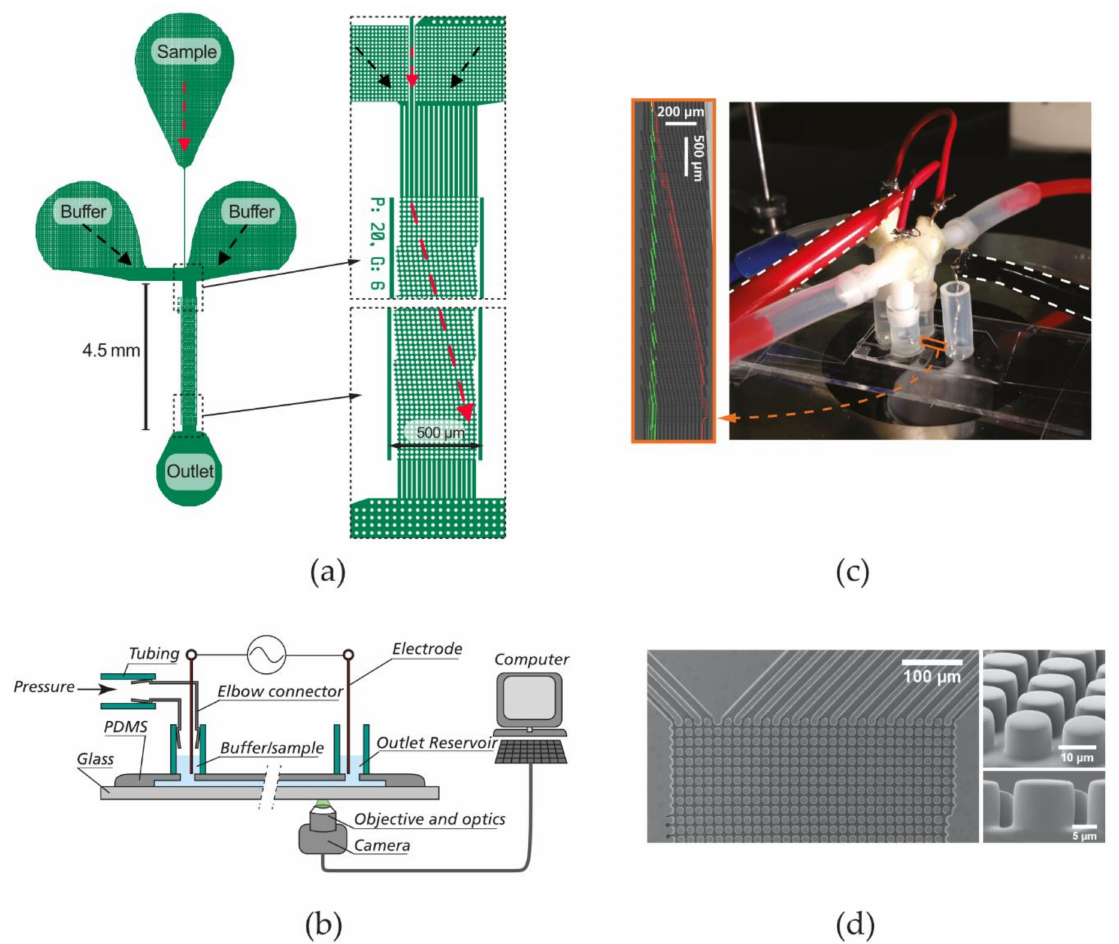
Figure 2. Devices and experimental setup. ( a ) Overview of device design. The red arrows schematically represent the trajectory of displacing particles. The actual trajectory angles of di ff erent devices are given in Table S2 of the Supplementary Information. Drawings are to scale. ( b ) Schematic of the experimental setup. ( c ) Image of the experimental setup, showing a DLD device on a microscope stage, with pressure and electrical connections. The electrical hooks are highlighted by the white dotted lines for visibility. The DLD array is enlarged and shown on the left, with color-coded trajectories of zigzagging (green) and displacing (red) particles. It has been compressed along its length by a factor of two to fit within the picture frame. ( d ) Scanning electron microscopic images of a typical DLD array (device #7, Table